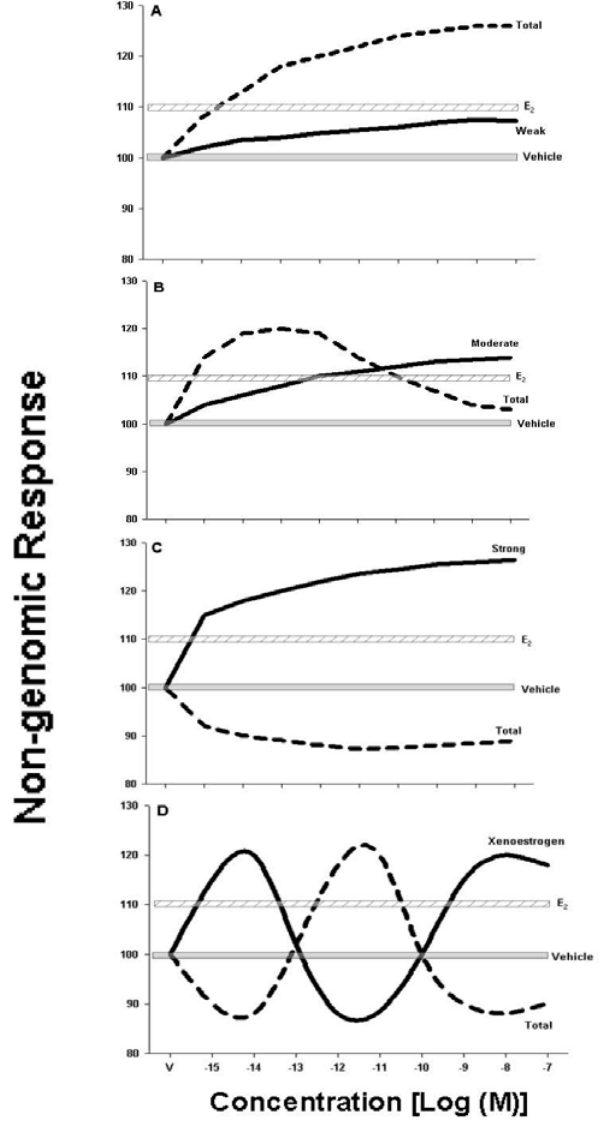
Figure 1. Working model of xenoestrogen (XE) alteration of physiologic estrogen non-genomic response effects. XEs of increasing dose were used to challenge the responses of the physiologic estrogen estradiol (10 − 9 M E ). These combinations examples 2 are mainly summarized from [25,26]. In each case the vehicle control (V) and 10 − 9 M E 2 responses are shown by horizontal bars. The response to an XE alone is shown by a solid line, and the combination of 10 − 9 M E plus the XE is shown by a dashed line. The types of 2 combination responses are: ( A ) A weak XE enhances the physiologic estrogen E response; 2 ( B ) A moderate XE response enhances the E response at low concentrations, and inhibits 2 it at higher concentrations; ( C ) The strongest XE inhibits the E response at all 2 concentrations, with increasing inhibition as the XE concentration increases; and ( D ) If the also fluctuates, in line with cases A–C above. These idealized data summarize what we have seen in combinations using a variety of XEs. Depending on the estrogenic potency of the XE, when paired with a physiologic estrogen, an inverse relationship in responses occurs (enhancement or